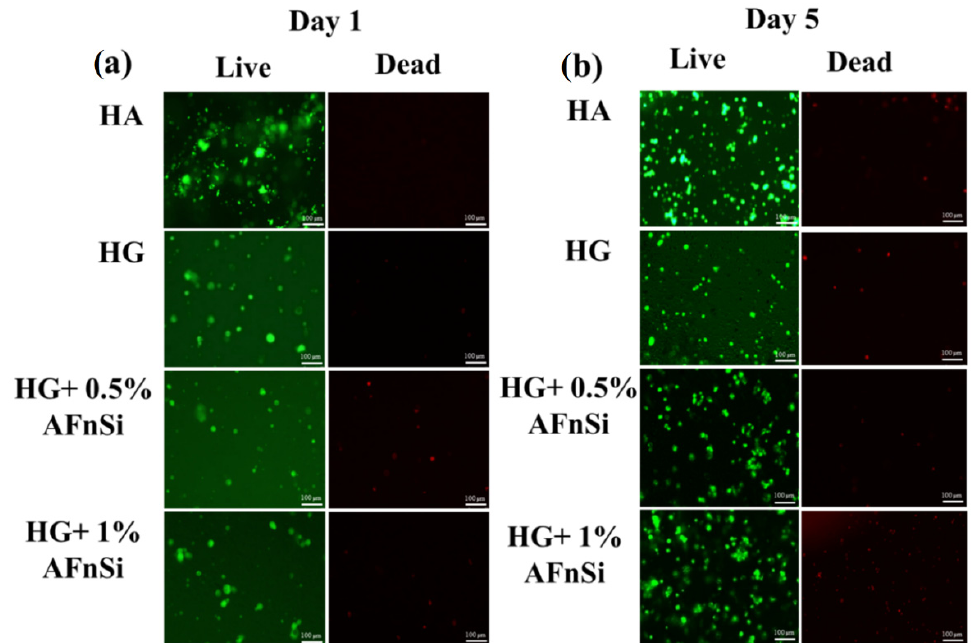
Figure 11. Fluorescence images observation by live and dead staining in hADSCs were cultured with the photocured hybrid hydrogel of HG, HG+0.5% AFnSi, and HG+1% AFnSi on day 1 ( a ) and day 5 ( b ), respectively. HA was used as control. The scale bar represents 100 µm. Results in all groups indicated that most of the hADSCs were still alive on day 1 and day 5, with only a small number of dead cells seen, which comprised the HA and the